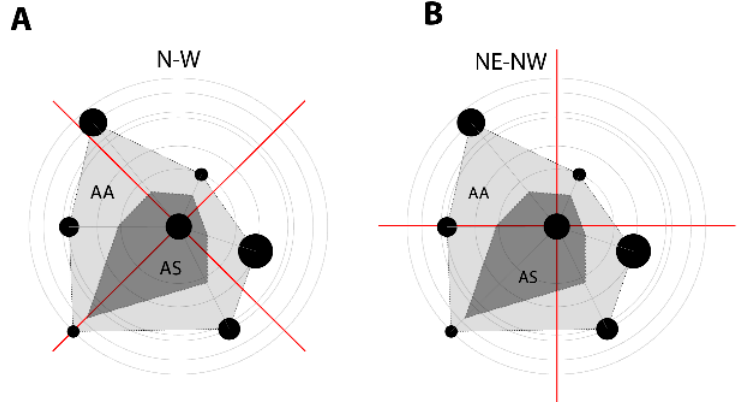
Figure 2. Two systems [N-W ( A ) and NE-NW ( B )] of social area segmentation used for detecting the largest and smallest relative sector of tree social area (AS). The black points with different size represent each tree and its’ dimension. AA represents spatially-available area for a particular tree.